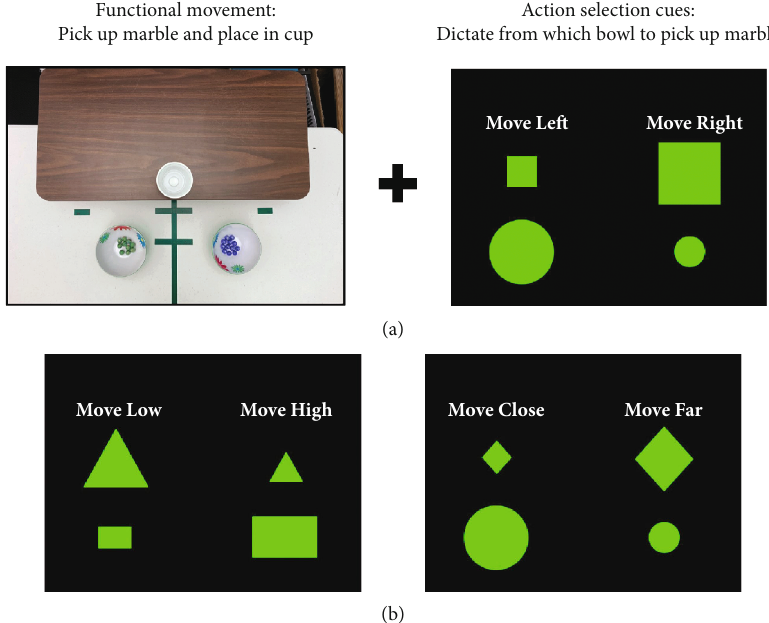
Figure 1: Example of training task with action selection cues. (a) Training involved task-oriented training (e.g., functional movement of picking up a marble and placing it into a cup) with the addition of action selection demands to each movement repetition (e.g., visual cues dictated whether the marble should be picked up from the right bowl or the left bowl on each movement repetition). (b) The action selection rule varied (shapes and rules were changed to maintain challenge) and was used to provide selection of movements to the right or left, to a low surface or a high surface (e.g., pick up marble from the low table or the high table), or to a close location or a far location (e.g., pick up a marble from a close bowl or a far